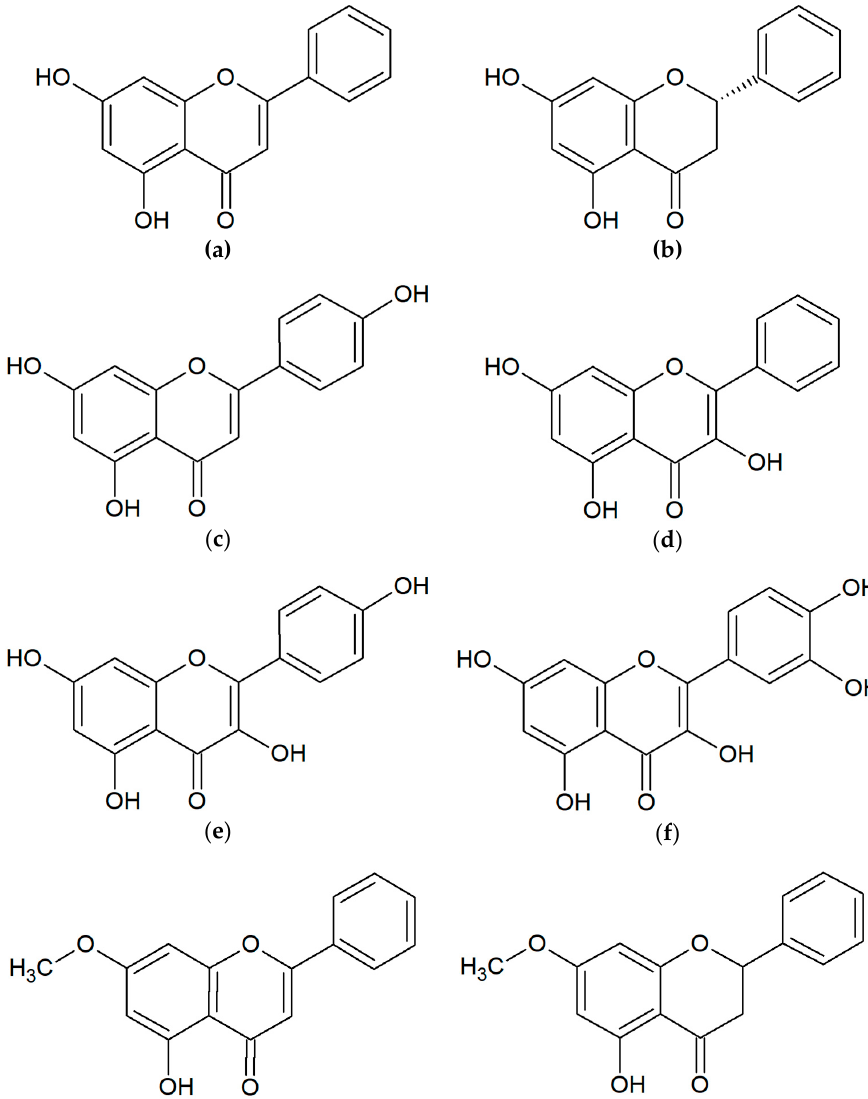
Figure 2. Flavonoids found in propolis: ( a ) chrysin; ( b ) pinocembrin; ( c ) apigenin; ( d ) galangin; ( e ) kaempferol; ( f ) quercetin; ( g ) tectochrysin; ( h ) pinostrobin.